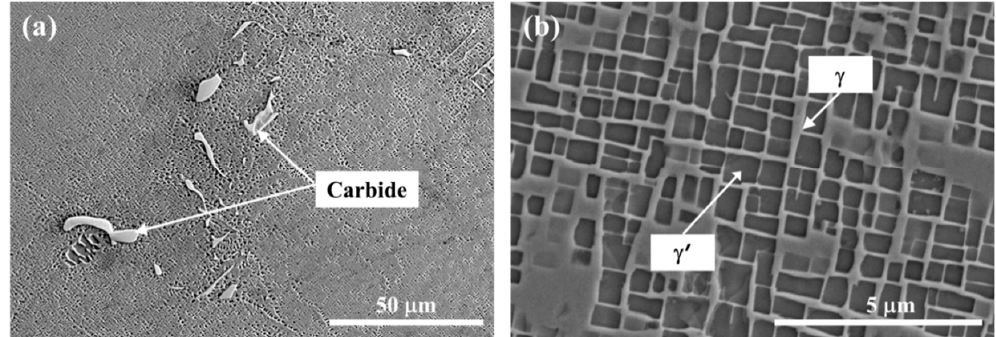
Figure 4. ( a ) Microstructure of SX René N5 showing the formation of carbide precipitates. ( b ) A ( a ) Microstructure of SX Ren é N5 showing the formation of carbide precipitates. representative image showing the formation of γ / γ′ microstructure in SX René N5. ( b ) A representative image showing the formation of γ / γ (cid:48) microstructure in SX Ren é